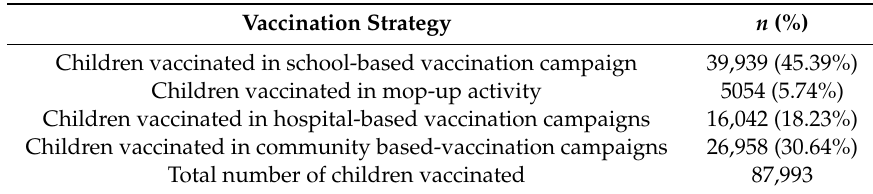
Table 2. Total number of children vaccinated in Lyari Town using di ff erent strategies.